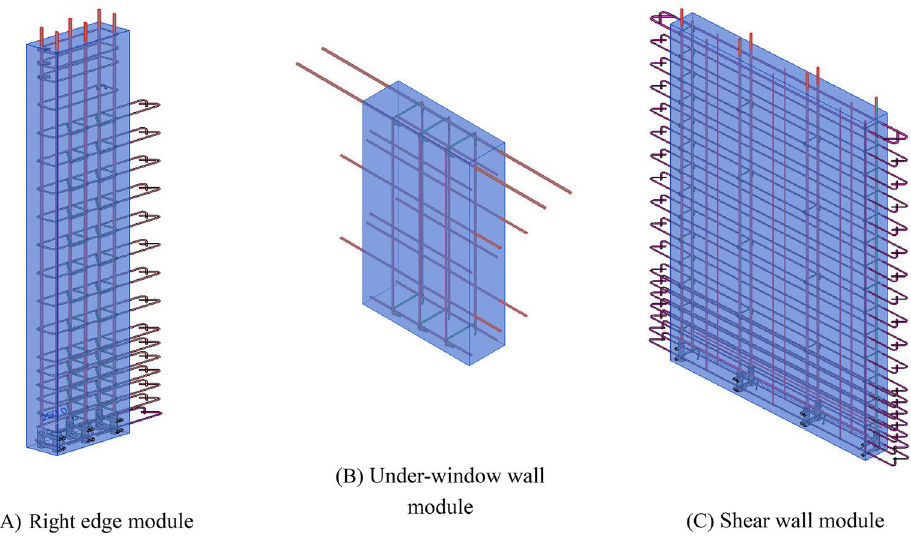
Figure 9. BIM model of modules.